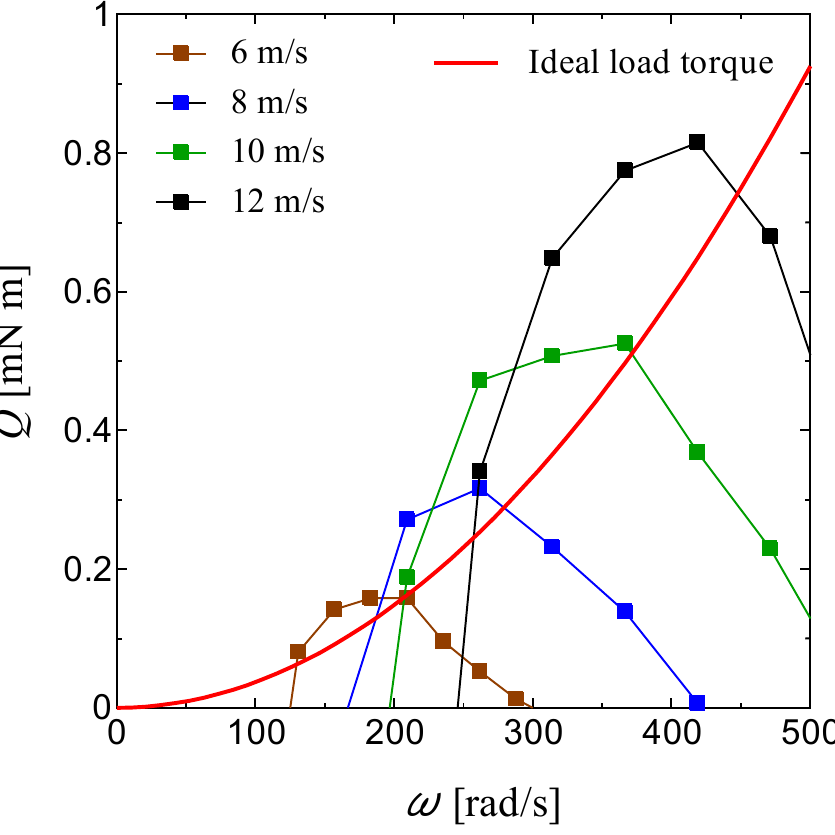
Figure 2. Torque curves of 2D-CFD rotor and ideal load torque curve. Values of torque were converted to corresponding values of 3D-EXP rotor.